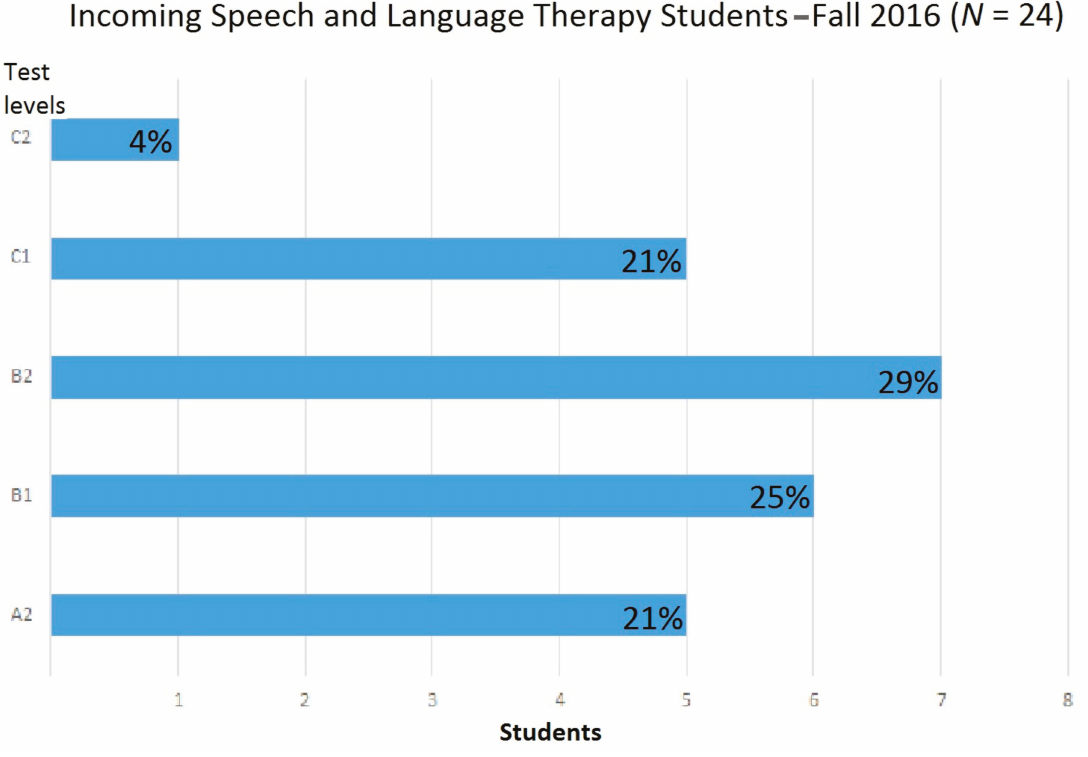
Figure 1. Fall 2016 English Computer-Adaptive Test results relative to Common European Framework of Reference sublevels